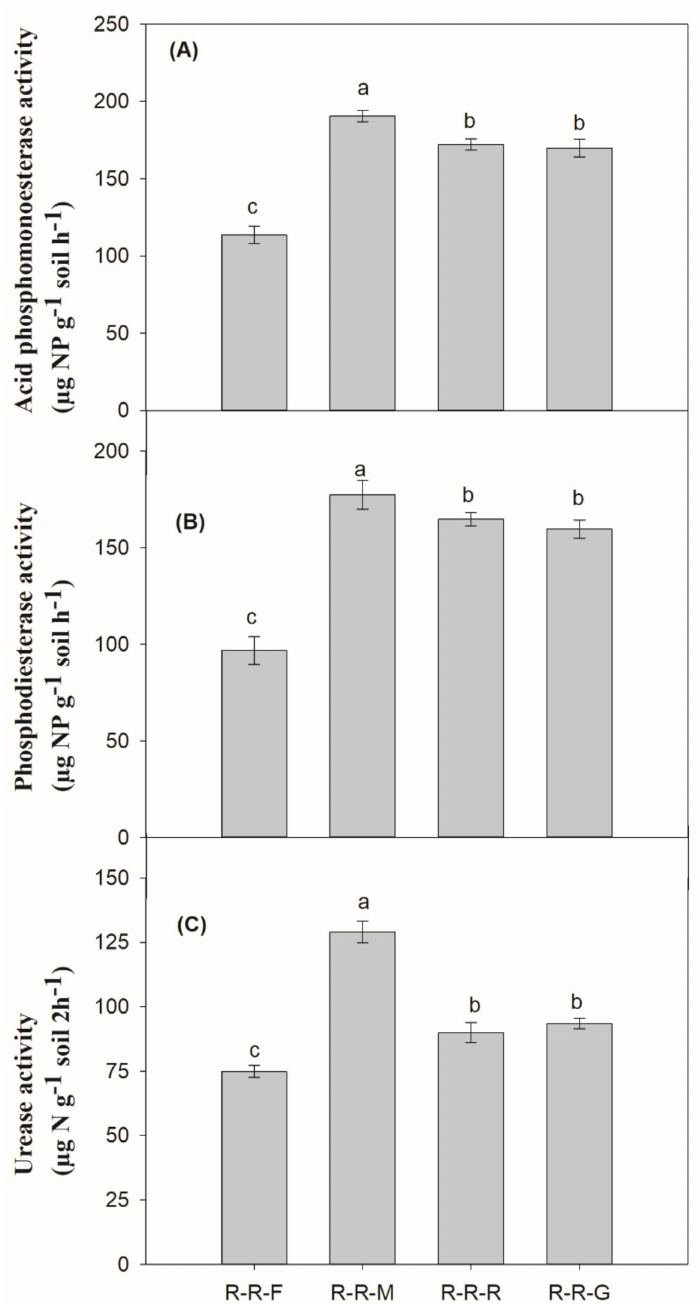
Figure 5. E ff ect of di ff erent long-term green manure rotations on enzyme activities in acidic paddy soil. Error bars represent ± standard deviations; di ff erent letters over the bars indicate significant ( p ≤ 0.05) di ff erences according to Tukey’s LSD